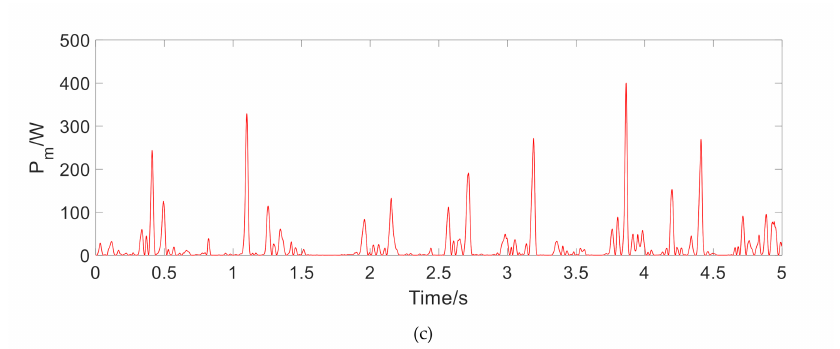
Figure 9. The instantaneous output power of regenerative motor under the random road. ( a ) Output